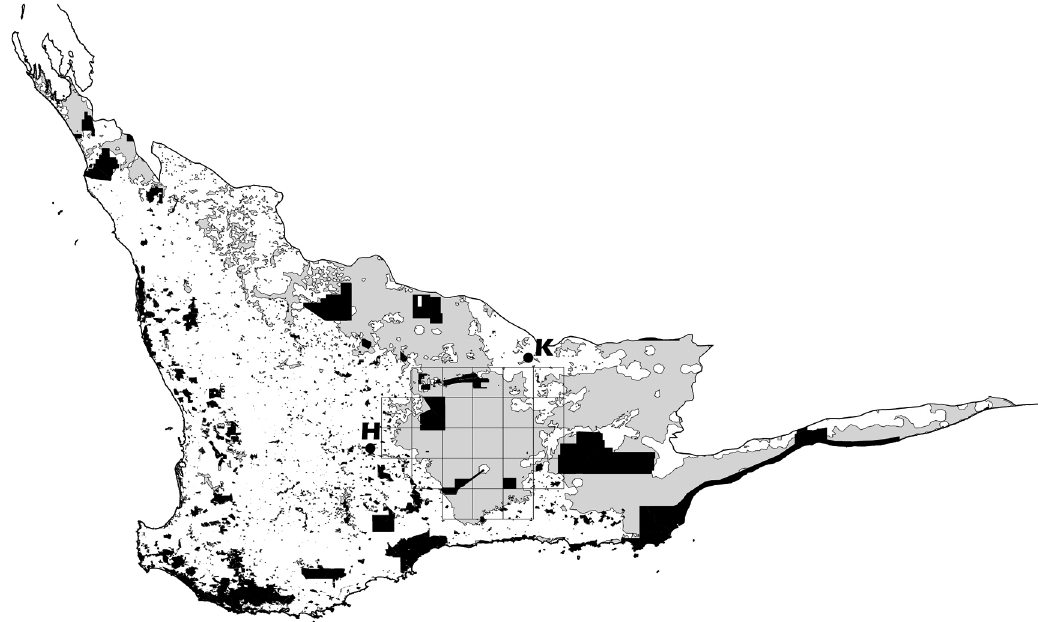
Fig. 2. Mediterranean southwestern Australia sensu Wilson et al. (2007) and the location of our study area (grid) shown in relation to categories 0 and I (e.g. intact vegetation) in the VAST framework developed by Thackway and Leslie (2006) (grey). National parks and nature reserves (black), and Kalgoorlie (K) and Hyden (H) are